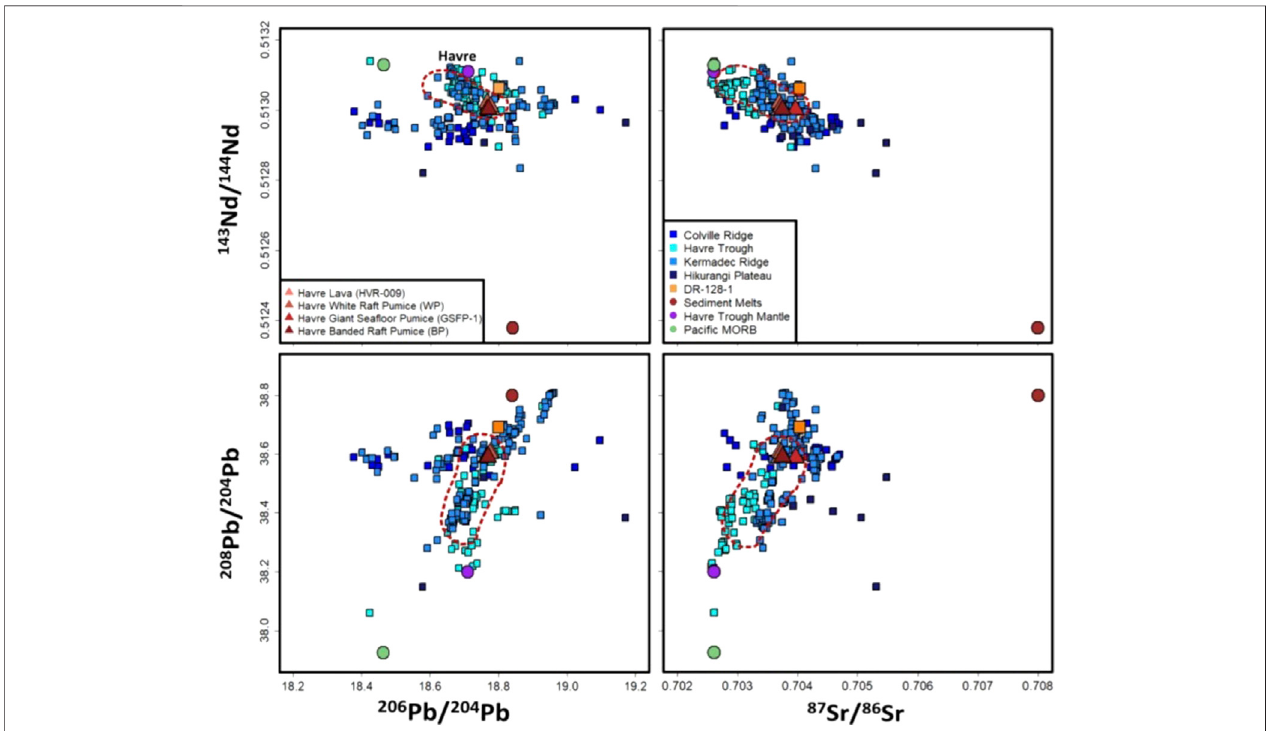
FIGURE 7 | Radiogenic isotope ratios (Pb, Sr, and Nd) of four Havre pumice and one Havre lava (triangles) compared with regional data (blue squares) for Kermadec Ridge, Havre Trough, Colville Ridge, and Hikurangi Plateau (Barker et al., 2013; Timm et al., 2014; Hauff et al., 2021). Havre lavas are outlined with a dashed red line. The orange square (DR-128 – 1) represents the isotopic composition of the parental basalt used for rhyolite-MELTS models. The pumice isotope ratios are identical to the Havre lava sample except for one pumice sample with a slightly elevated Sr ratio, consistent with seawater contamination. Local estimates of sedimentmelt(redcircle),HavreTroughmantle(purplecircle)fromHaaseetal.(2002),andaveragePaci fi cmid-oceanridgebasalts(greencircle)fromWhiteetal.(1987) are also shown. The measured ratios from this study closely resemble mantle-derived basalts characteristic of the mantle in this region and do not suggest the assimilation of continental